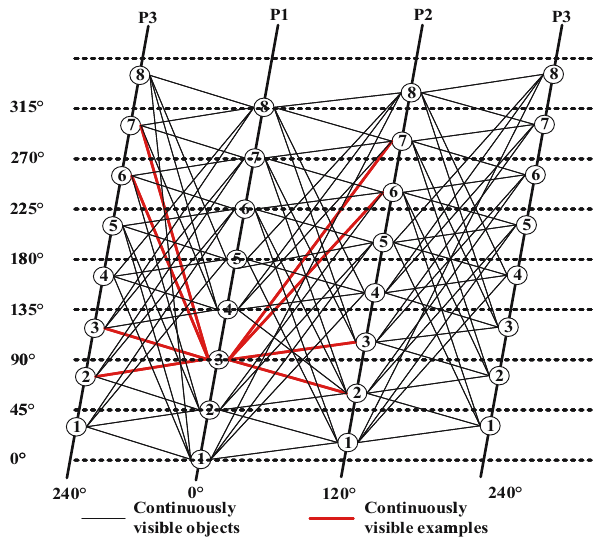
Figure 1: Topology of a non - transitory link in a non - time - varying link.